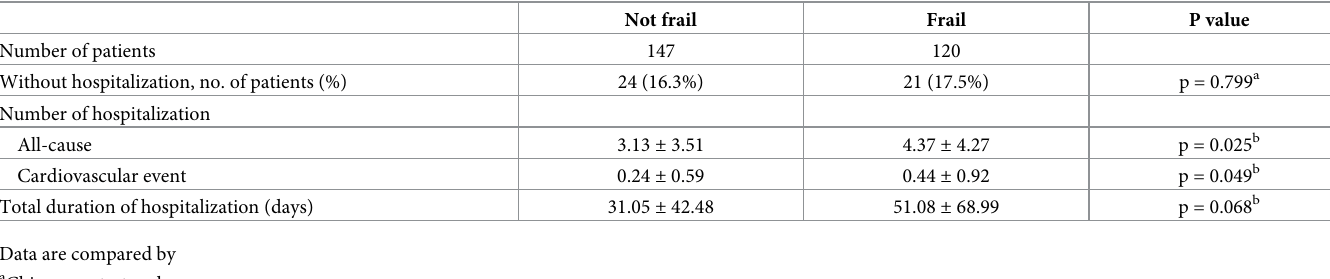
Table 4. Relation between physical frailty and hospitalization.